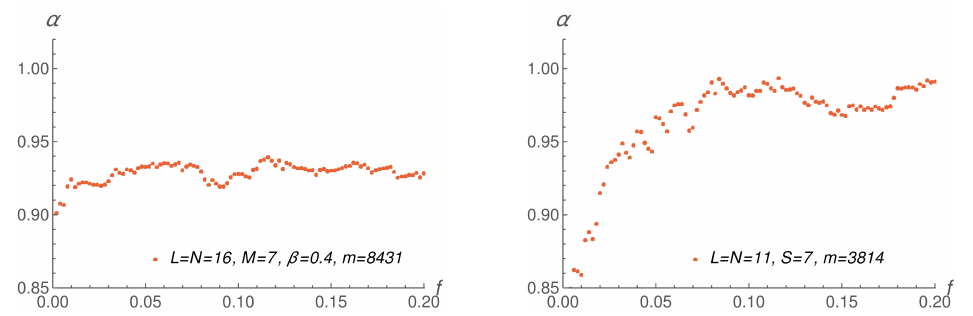
Figure 10: Values of α for the Wigner-Dyson distribution which best fit the data under different clipping fractions f of low-energy states (we clip 4% of the high- energy levels). On the left we consider the β -deformed theory, while on the right = 50 in both cases. In order for the we consider the sl ( 2 ) sector of N = 4, with n b results of the undeformed theory to be stable, one needs to clip a larger percentage of states.